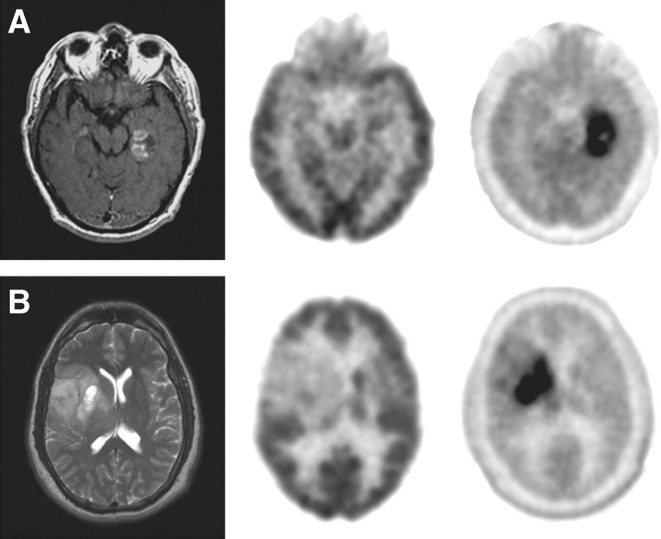
MRI (left), 18F-FDG PET (middle), and 18F-FDOPA PET (right) of newly diagnosed tumors. (A) Glioblastoma. (B) Grade II oligodendroglioma. This research was originally published in Chen et al. (95).